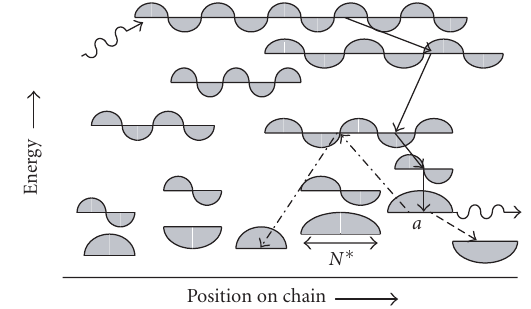
Figure 5: Schematic picture of the localized exciton wave functions near the lower band edge in a disordered linear chain. Also indicated are the optical pumping and emission processes (wavy arrows) and various intraband relaxation processes (straight